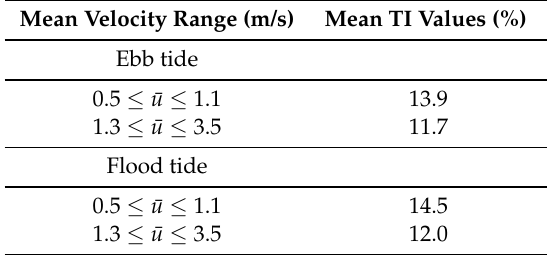
Table 1. Turbulence intensity values used to generate time series of tidal stream velocity.